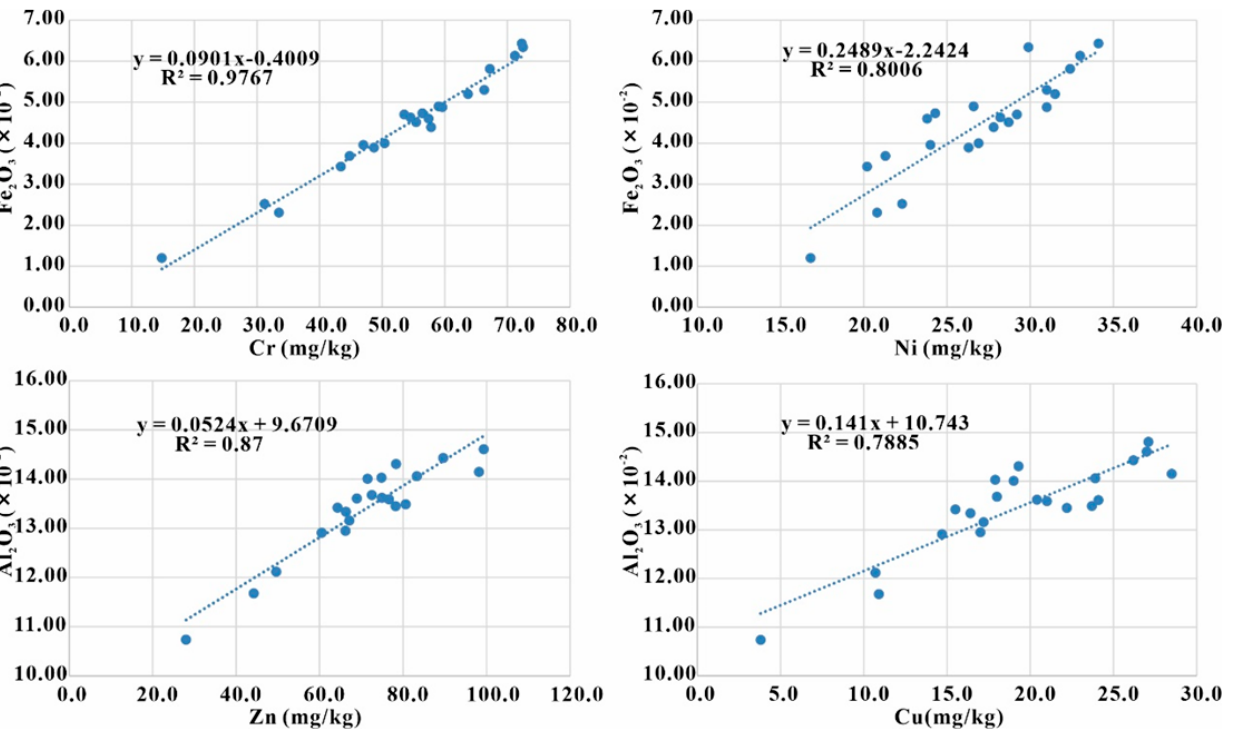
Figure 10. Distribution diagram of Cr, Ni, Zn and Cu (mg/kg) versus Al 2 O 3 and Fe 2 O 3 (wt%) in the surface sediments of Yueliang Lake.